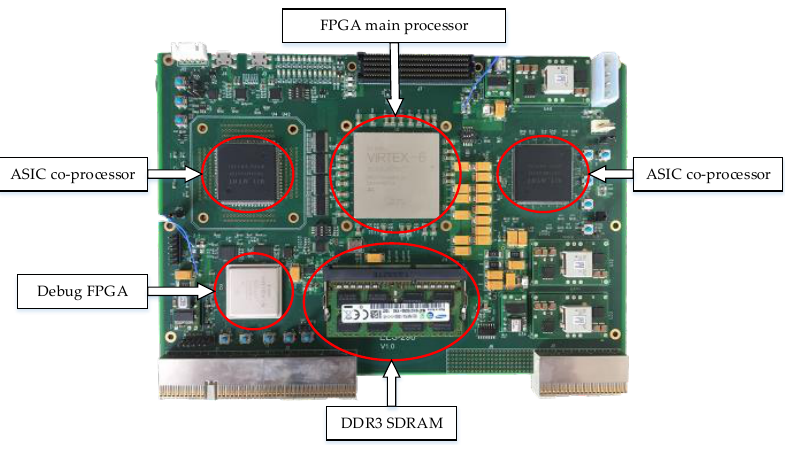
Figure 14. Photo of the hardware system.